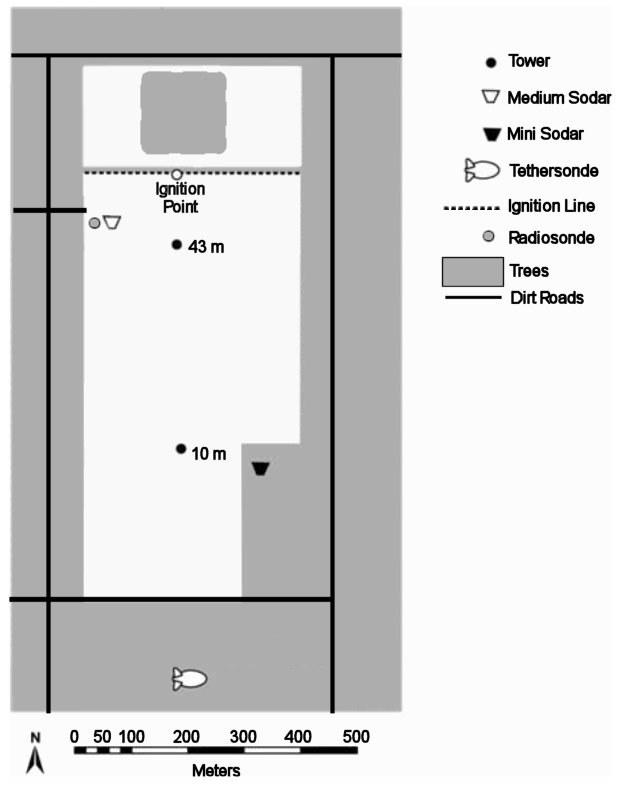
Fig. 1. Instrument locations and the layout of the FireFlux experi- ment. White area indicates